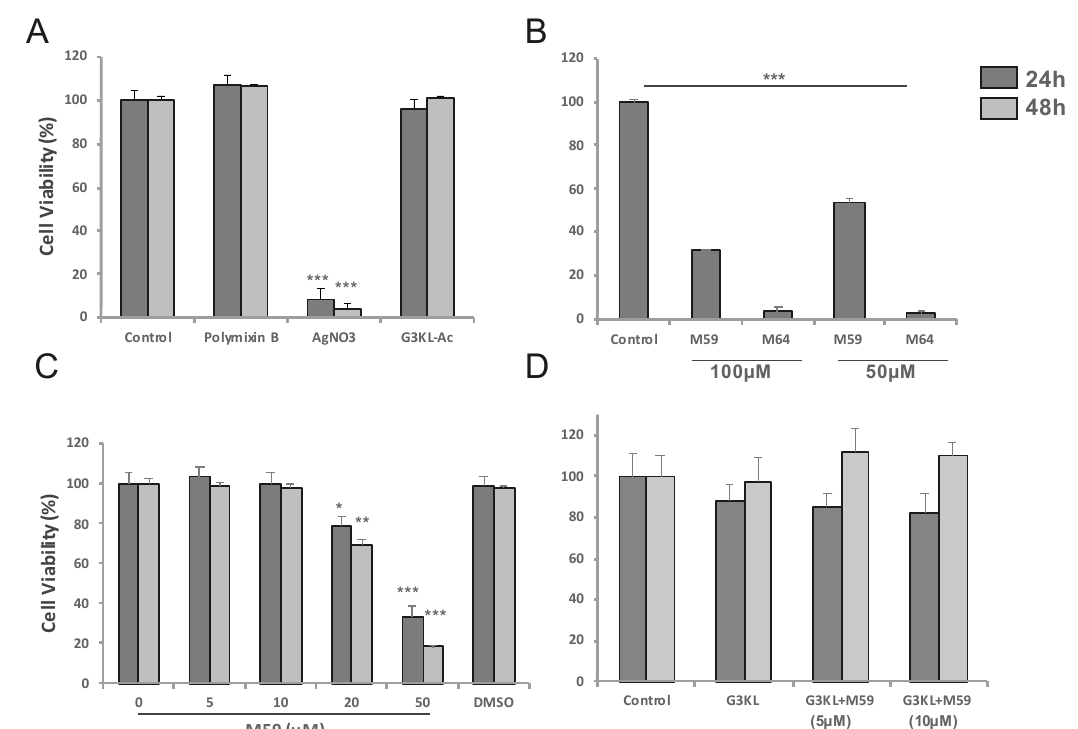
Figure 3. Assessment of the viability (MTT assay) of human progenitor fibroblast cells incubated with different antimicrobial compounds in 2D cultures. Cells were cultured for 24 to 48 h in the presence of: ( A ) acetate salt of G3KL as compared to antibiotic polymyxin B (12.5 µg/mL) and non-antibiotic antimicrobial silver nitrate (AgNO 3 ; 6.25 µg/mL); ( B ) two QS-inhibitors (M59 and M64) at different concentrations; ( C ) lower M59 concentration; ( D ) G3KL in combination with M59. Bar charts show the percentage of viable cells quantified using the MTT assay, in comparison to the untreated live cells (100%). Data are presented as the means ± SD ( n = 3). p values were determined by unpaired Student’s test. * p ≤ 0.05, ** p ≤ 0.01, *** p ≤ 0.001.